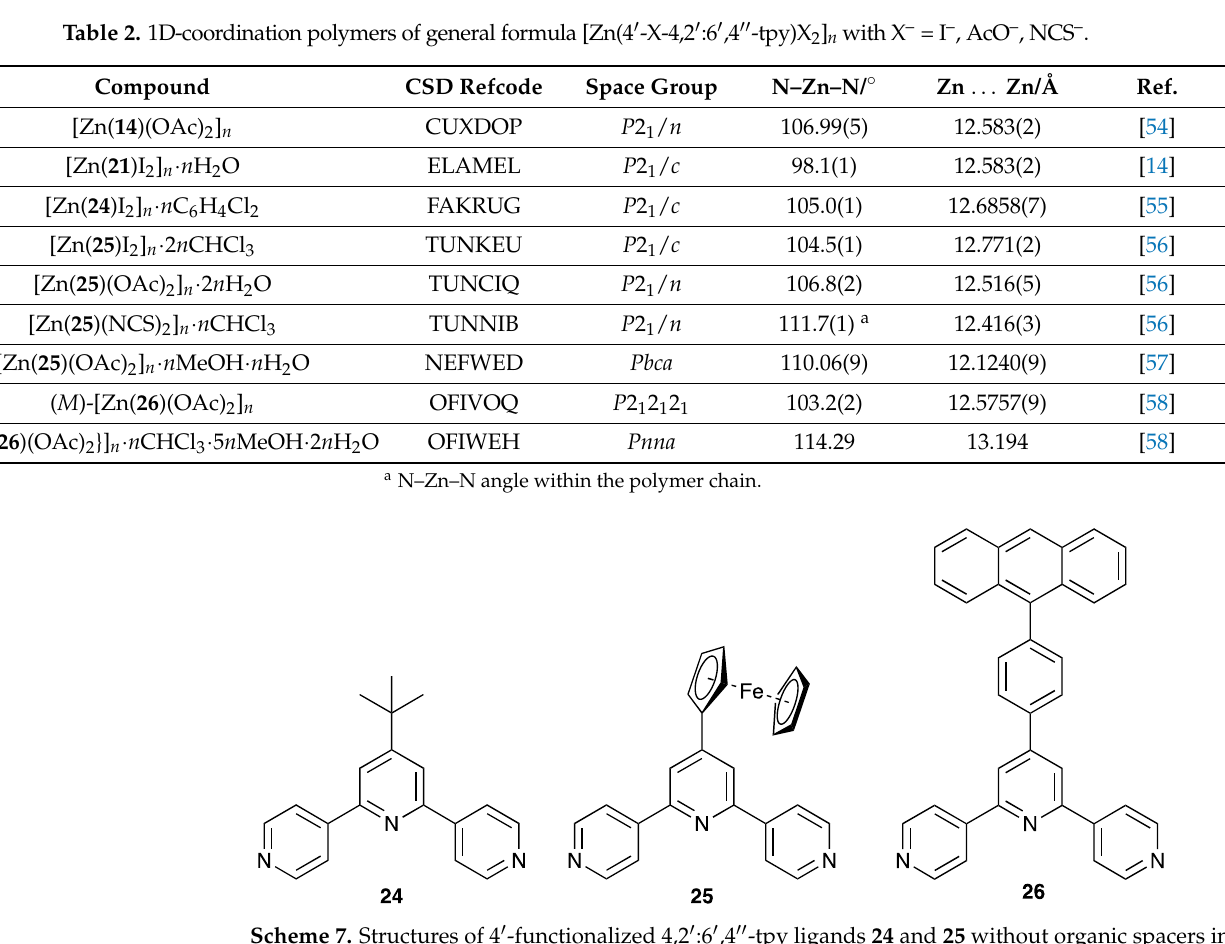
Scheme 7. Structures of 4’ ‐ functionalized 4,2’:6’,4” ‐ tpy ligands 24 and 25 without organic spacers in the 4’ ‐ position, and the structure of 26